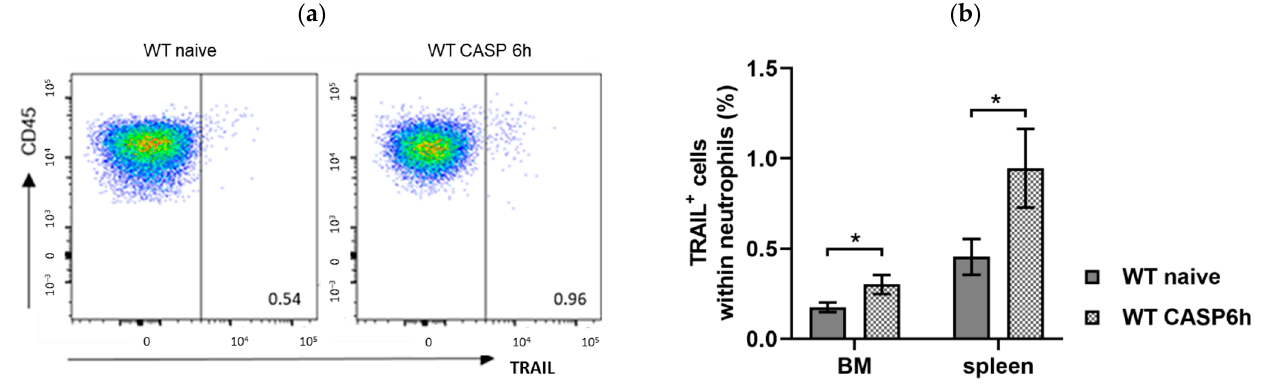
Figure 6. Impact of 6h CASP on the expression of TRAIL in neutrophils from BM and spleen. TRAIL was stained and assessed by FACS. ( a ) Representative FACS plots show TRAIL-positive neutrophils. ( b ) Quantification of TRAIL expression in neutrophils of naïve and septic WT mice ( n = 5 each). Graphs show mean ± SEM (* p < 0.05).